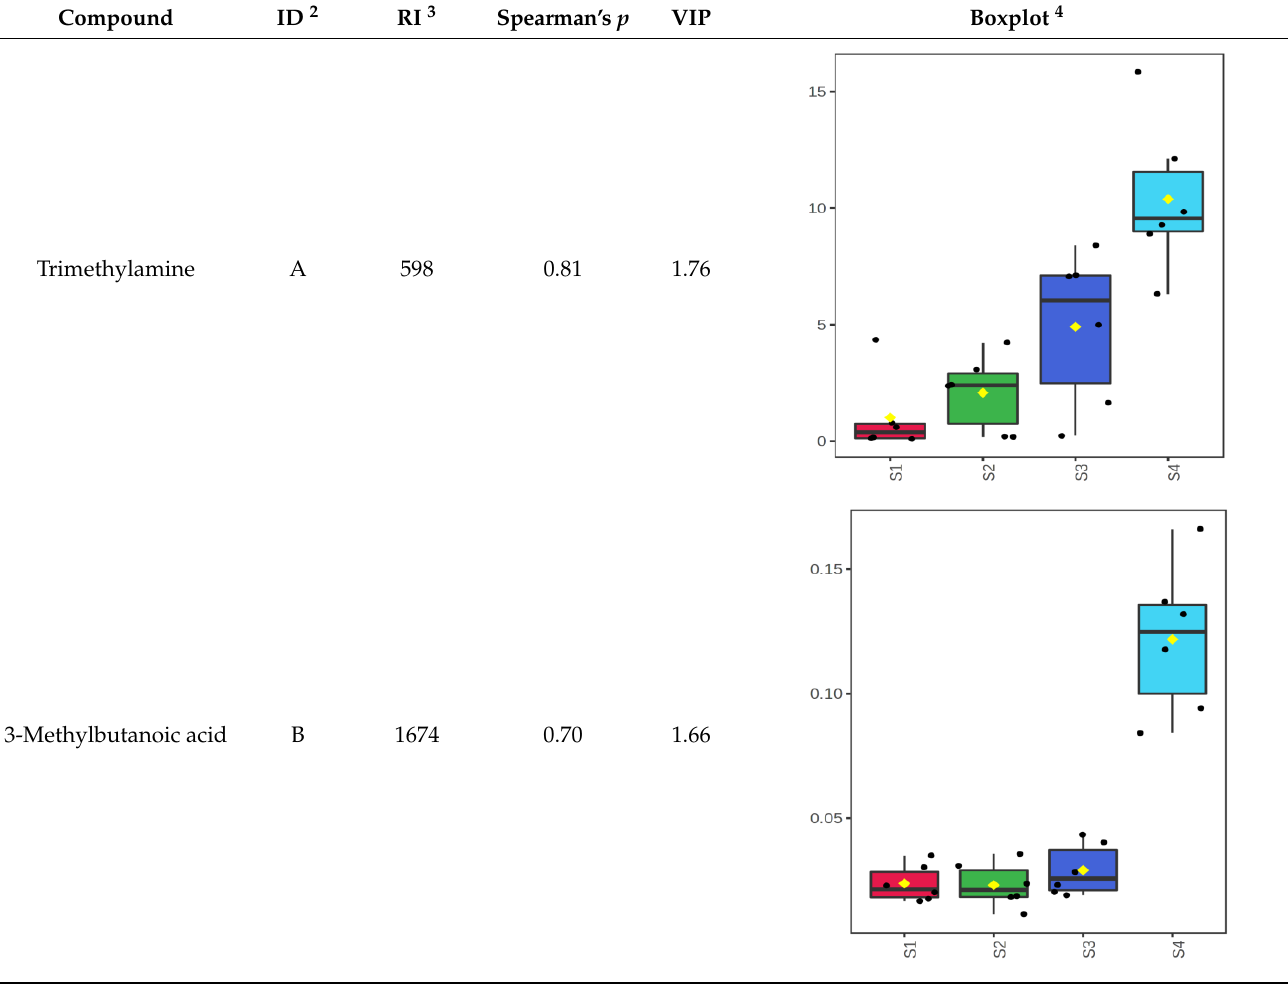
Table 1. Volatile compounds correlated significantly 1 with the storage period of whole meagre on ice. Compound